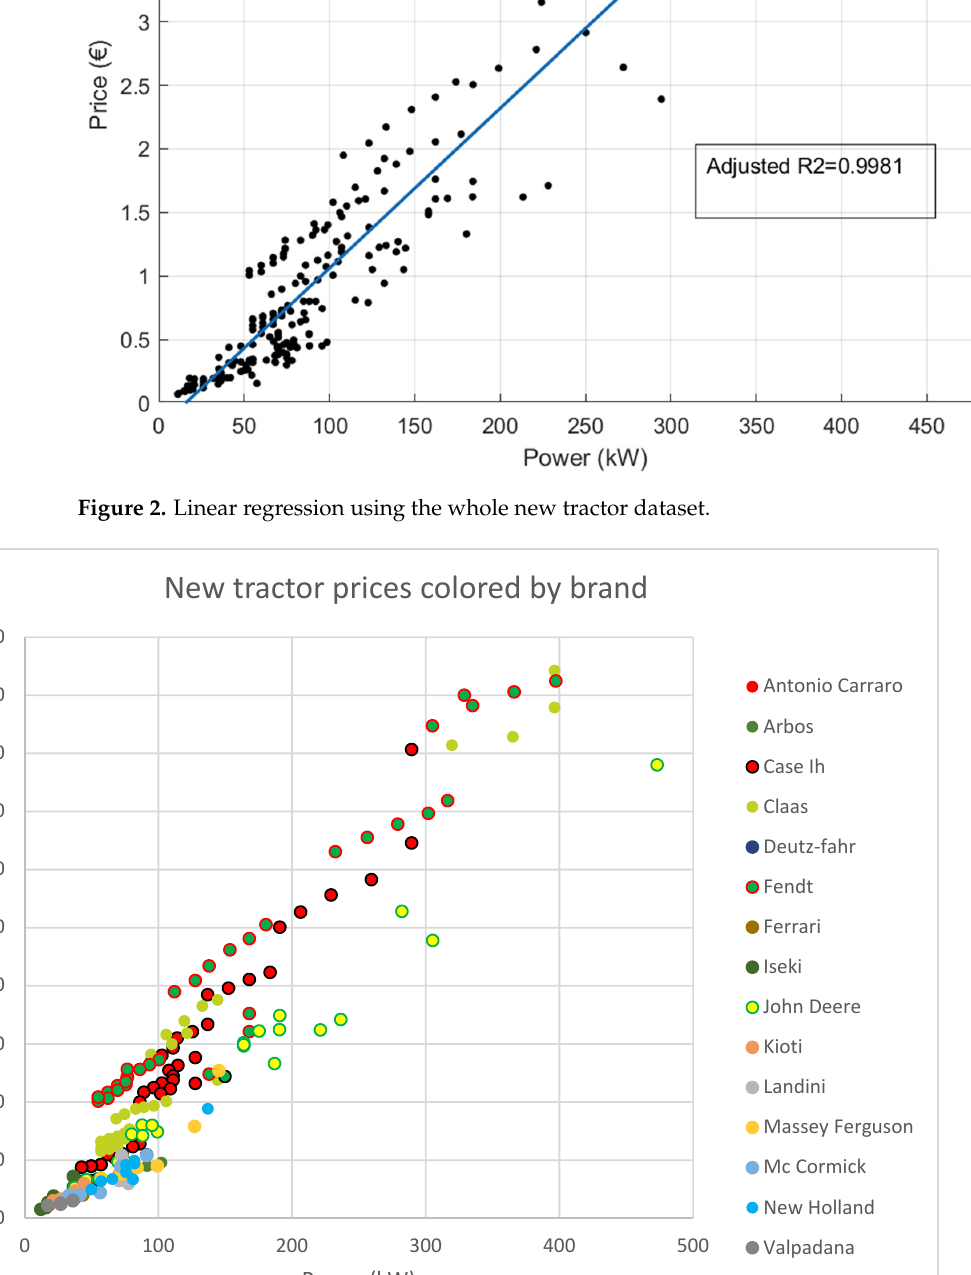
Figure 4. Price vs. power for Case IH new tractors.